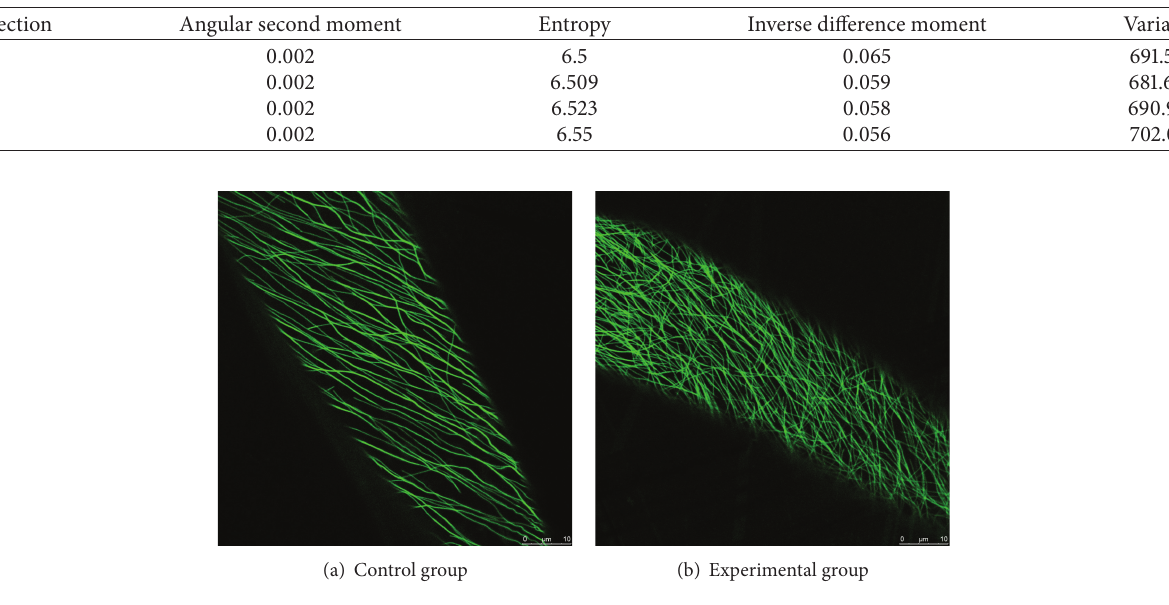
Figure 4: Two different arrangement images of plant microtubules.